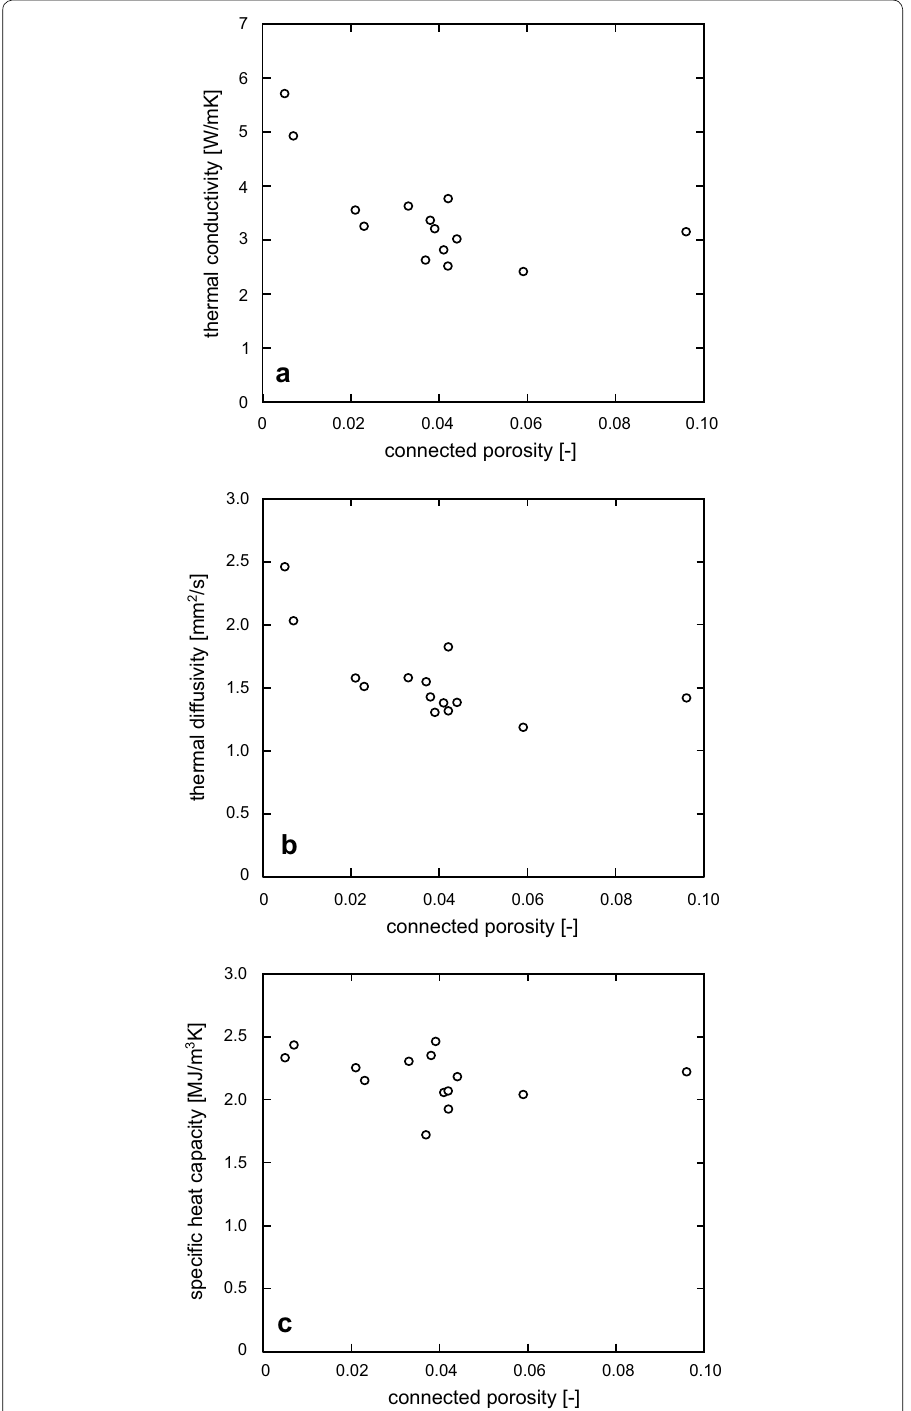
Fig. 7 a Dry thermal conductivity b dry thermal diffusivity, and c dry specific heat capacity per unit volume as a function of connected porosity for Muschelkalk samples from exploration well EPS-1